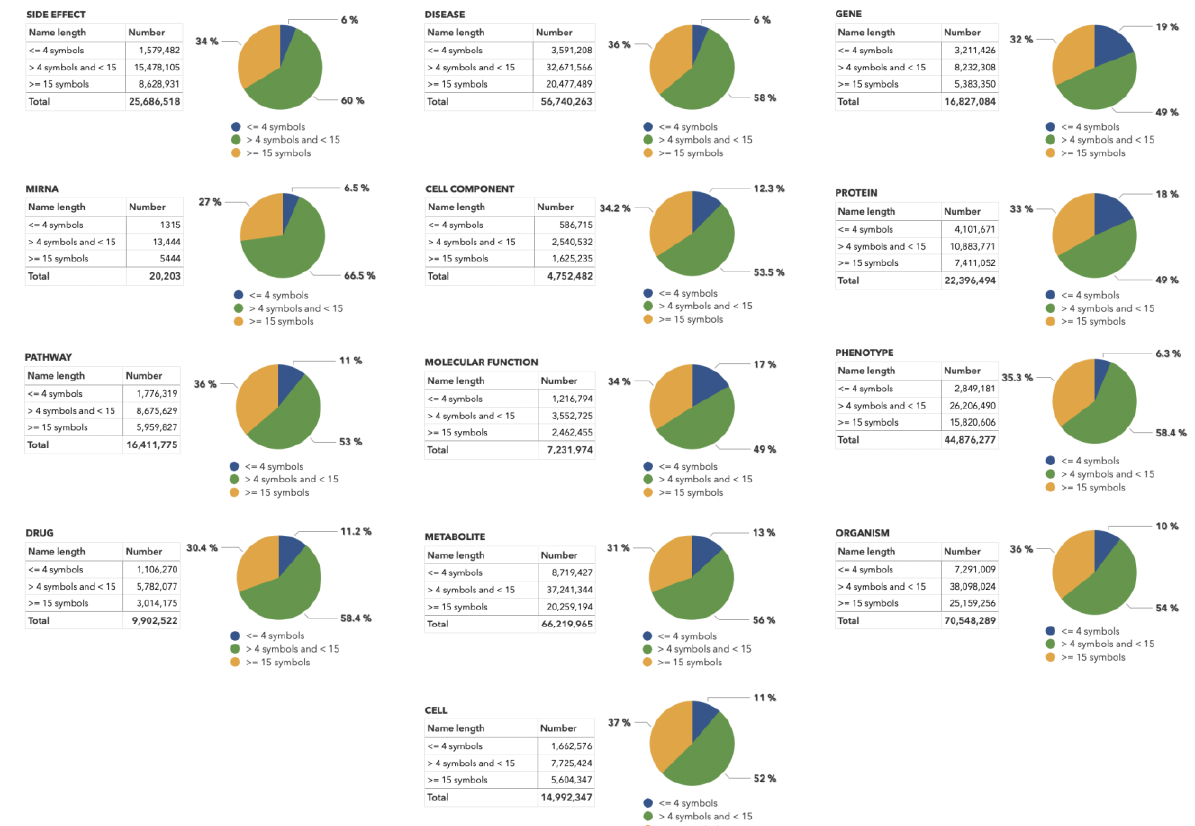
Figure 7. Distribution of biological object names from the ANDSystem ontology in PubMed abstracts according to their length and type. This distribution is based on the primary mapping of 34 million PubMed abstracts.